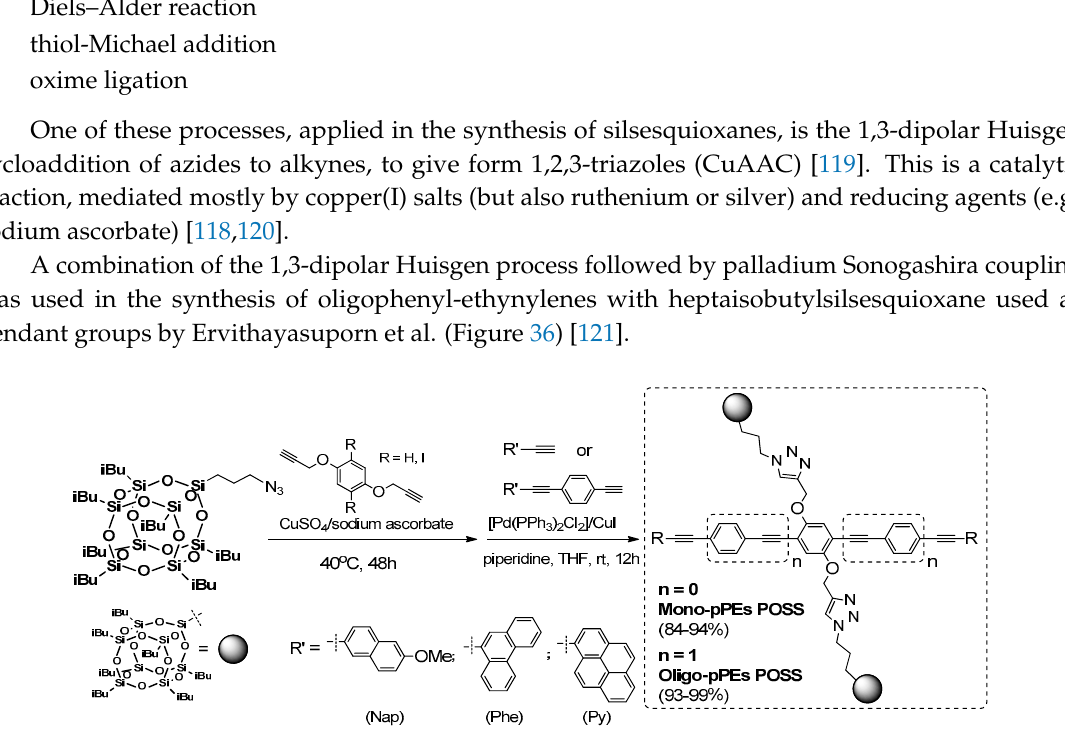
Figure 36. Synthesis of oligophenyl-ethynylenes with heptaisobutylsilsesquioxane as pendant groups via a 1,3-dipolar Huisgen reaction followed by palladium Sonogashira coupling.